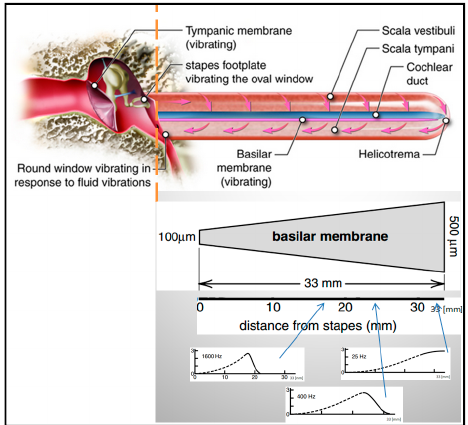
Figure 2. Human middle- and inner ear. Uncoiled cochlea with focus on the basilar membrane and the location of some of its excitable frequencies. The initial mechanical analysis in the ear is subsequently improved and sharpened by a data analysis network of neurons in the brain. Figure composed using original work by Cenveo